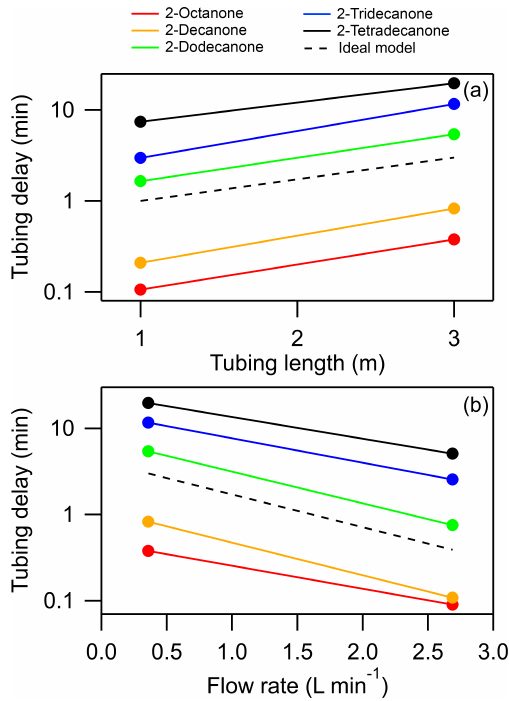
Figure 3. (a) Tubing delays for PTR-MS analysis of 2-ketones sampled using 1 and 3m of 3/16in. ID tubing at a flow rate of 0.36Lmin − 1 . The dashed line corresponds to the model case where the delay is proportional to the length of the tubing, which for these experiments is a factor of 3. (b) Tubing delays for PTR-MS analysis of 2-ketones sampled using 3m of 3/16in. ID tubing and flow rates of 0.36 and 2.7Lmin − 1 . The dashed line corresponds to the model case where the delay is inversely proportional to the flow rate, which for these experiments is a factor of